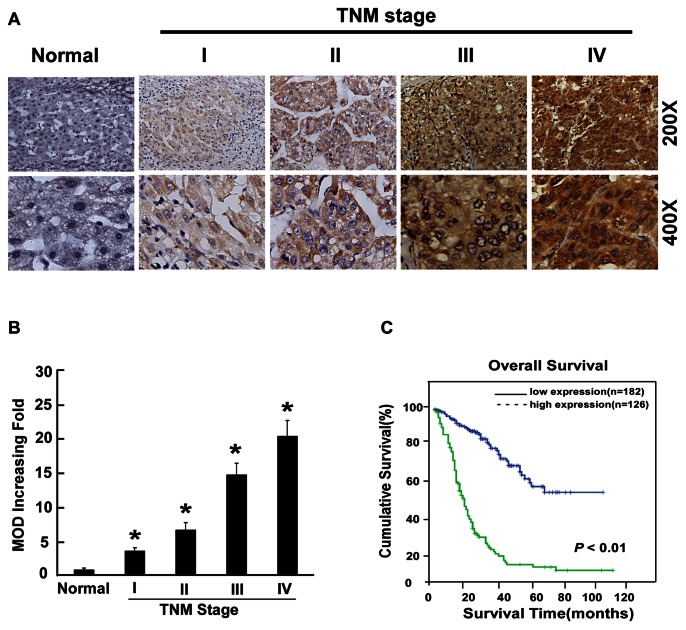
Overexpression of MACC1 in archived HCC.(A) Representative IHC analyses of MACC1 expression in normal liver tissue (Normal) and HCC specimens of different TNM stages. (B) Statistical quantification of the average MOD values of MACC1 staining between normal liver tissue (Normal) and HCC specimens of different TNM stages. The mean absorbance (MOD) of MACC1 staining increases as HCC progresses to a higher clinical stage. Error bars represent mean ± SD from three independent experiments. * P<0.05. (C) Kaplan–Meier curves with univariate analyses (log-rank) for patients with low- versus high-MACC1 expression.